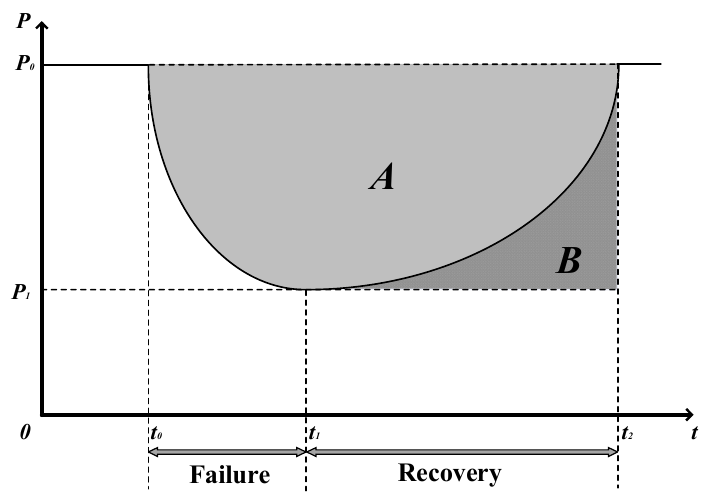
Figure 3. The failure and recovery process of system